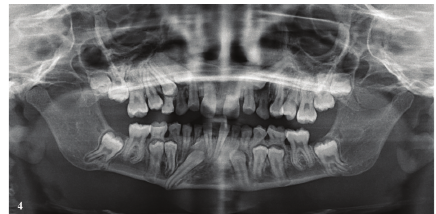
Figure 4: Panoramic radiograph showing an ectopically erupting mandibular right canine excessively tilted mesially and agenesis of lower lateral